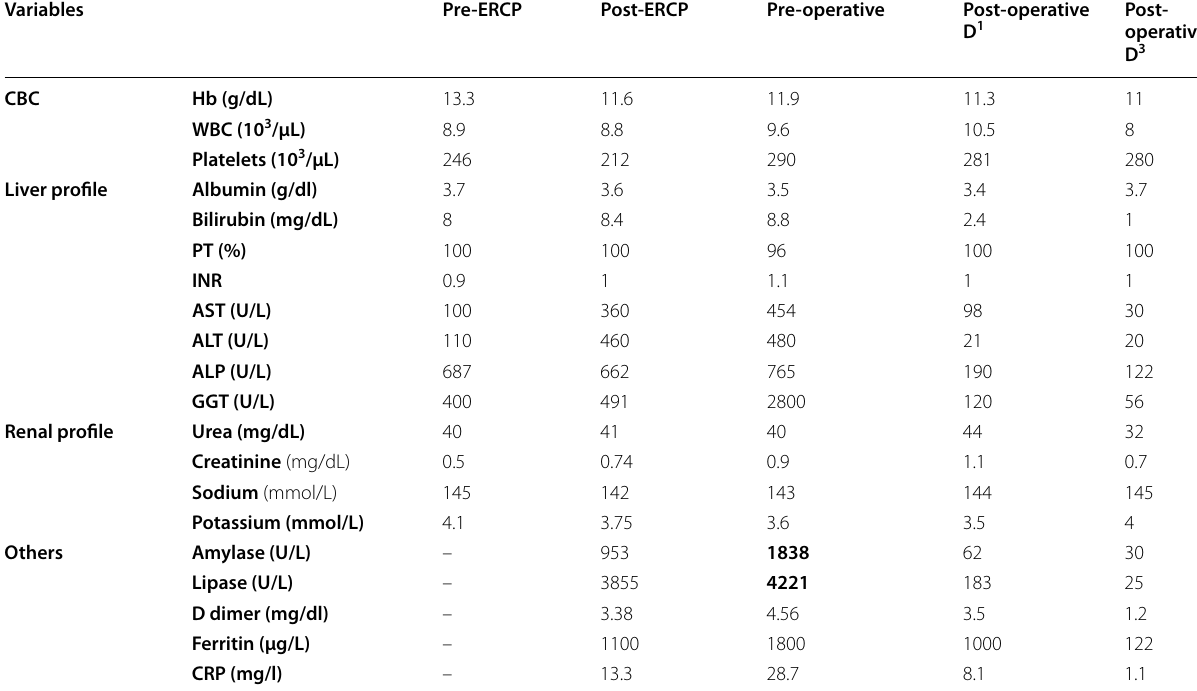
Table 1 Serial laboratory data of the case Variables